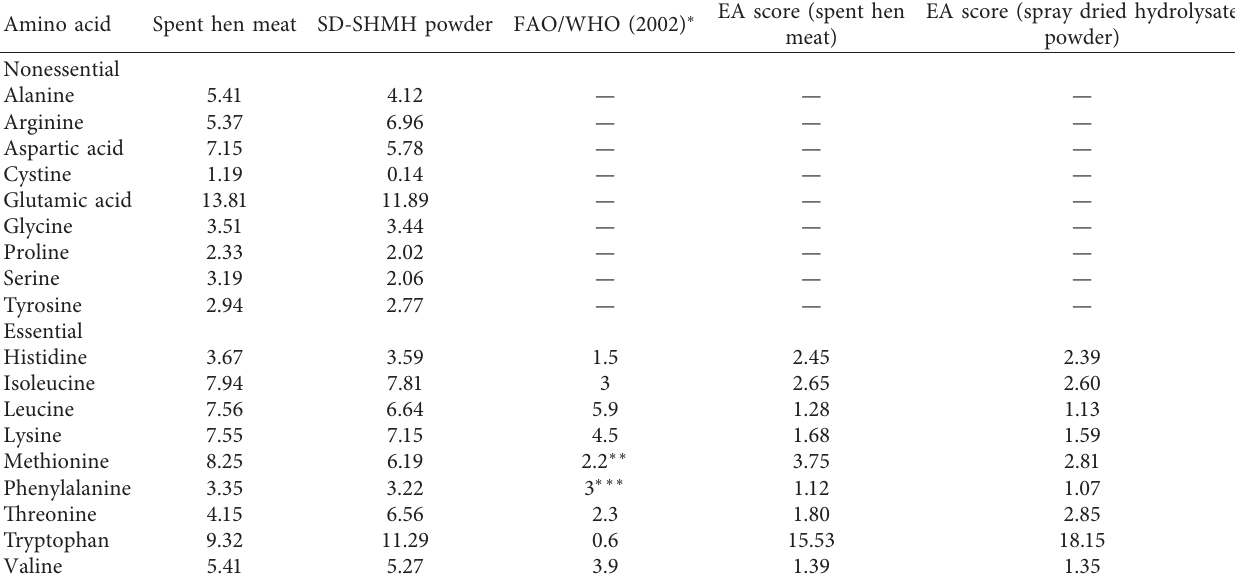
Table 3: Amino acid composition (g/100 g protein) of spent hen meat and spray dried spent hen meat hydrolysate powder. Amino acid